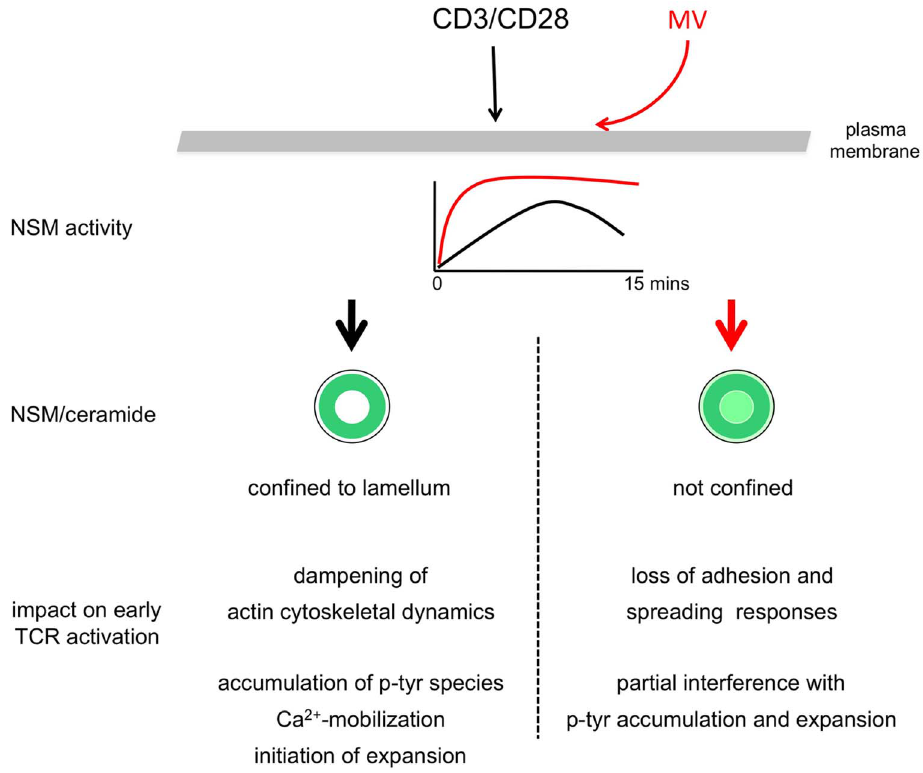
Fig. 7. Model of NSM-dependent T cell suppression. T cell co-stimulation induces transient activation of the NSM which, as ceramides, is confined at early stages to the lamellum (upper graph, black line, left sketch of the T cell IS). In the presence of MV, NSM is activated more rapidly and prolonged, and ceramides are not excluded from the IS center (upper graph, red line, right sketch of the T cell IS). Based on genetic ablation studies, under physiologic conditions, the NSM appears to dampen overshooting T cell activation by regulating the speed of early T cell activation as defined by the typical parameters listed. When inappropriately (time, magnitude) activated as occurring by MV T cell contact, the dampening role of NSM is exaggerated and associated with actin cytoskeletal paralysis, but also contributes to MV-induced loss of certain p-tyr protein species and expansion. Therefore, the ability of MV to cause NSM induction in a contact dependent manner accounts for major features of MV-mediated T cell suppression.